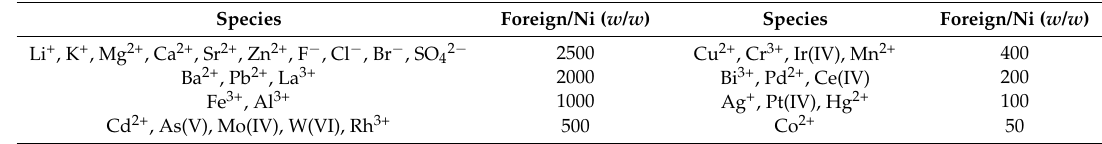
Table 2. Effect of foreign ions on the preconcentration/determination of nickel.